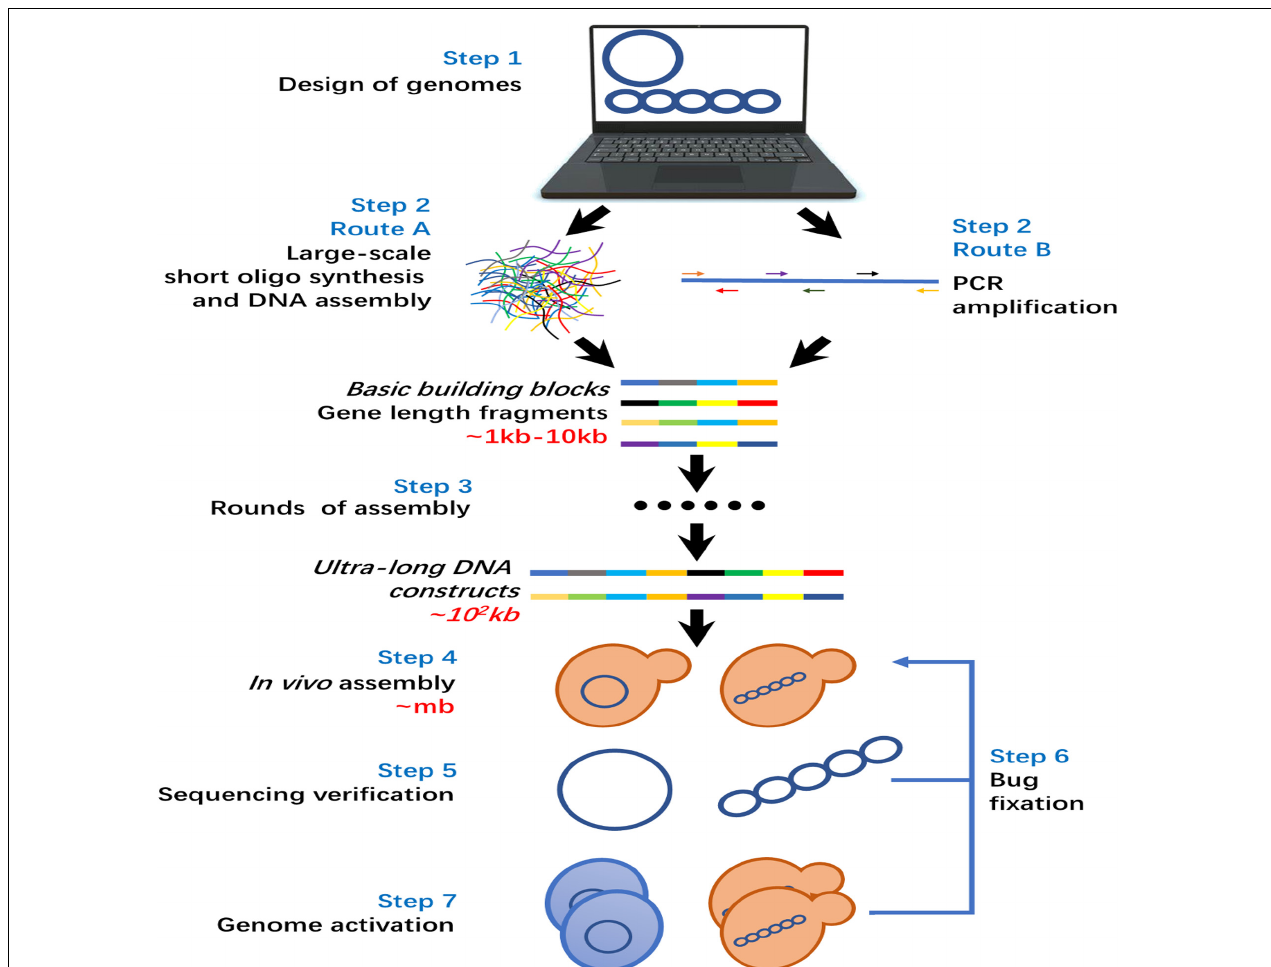
FIGURE 3 | General workflow of de novo whole-genome